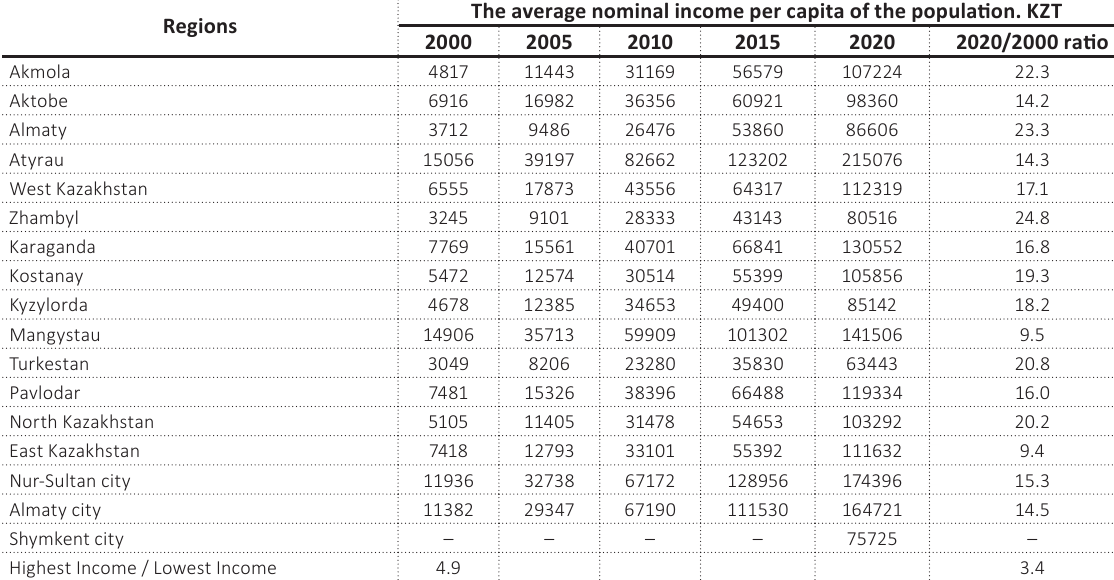
Table 2. Indicators of average nominal income per capita of Kazakhstan`s population Source: Bureau of National Statistics (2020). The average nominal income per capita of the population. KZT Regions